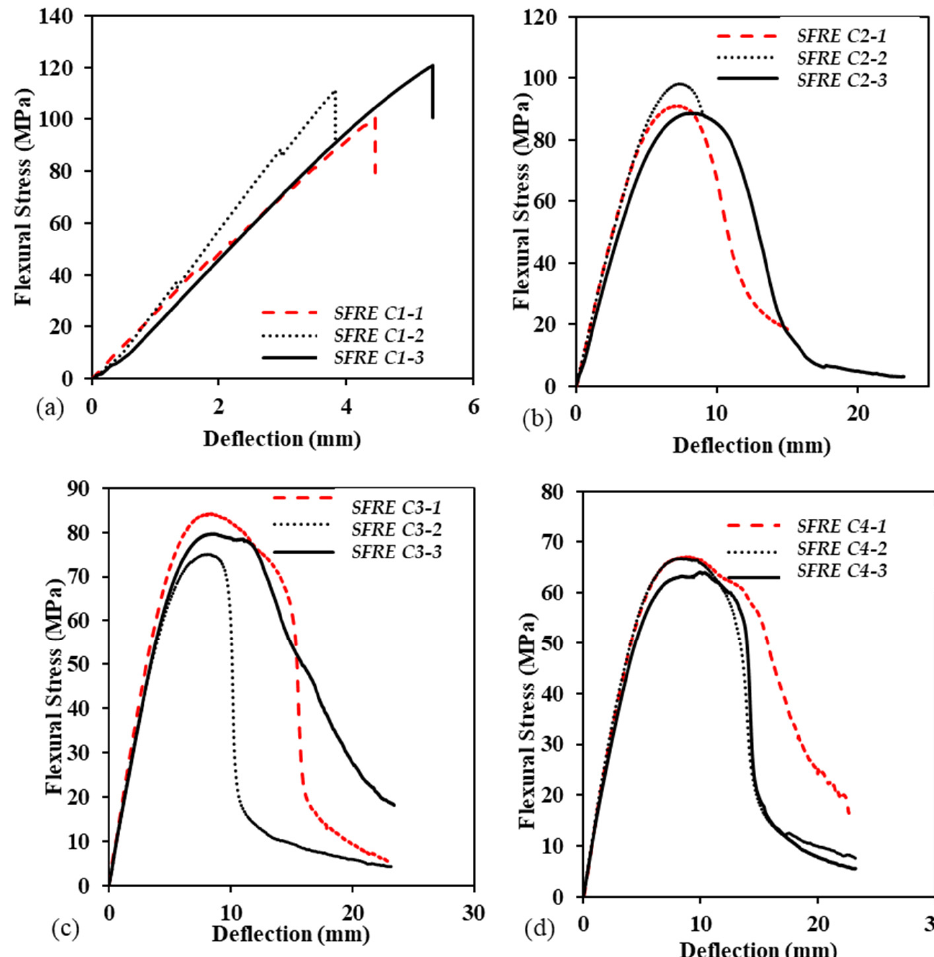
Figure 15. Flexural behaviour of SFRE samples under various hydrothermal conditions, ( a ) C1, ( b ) C2, ( c ) C3, ( d ) C4.